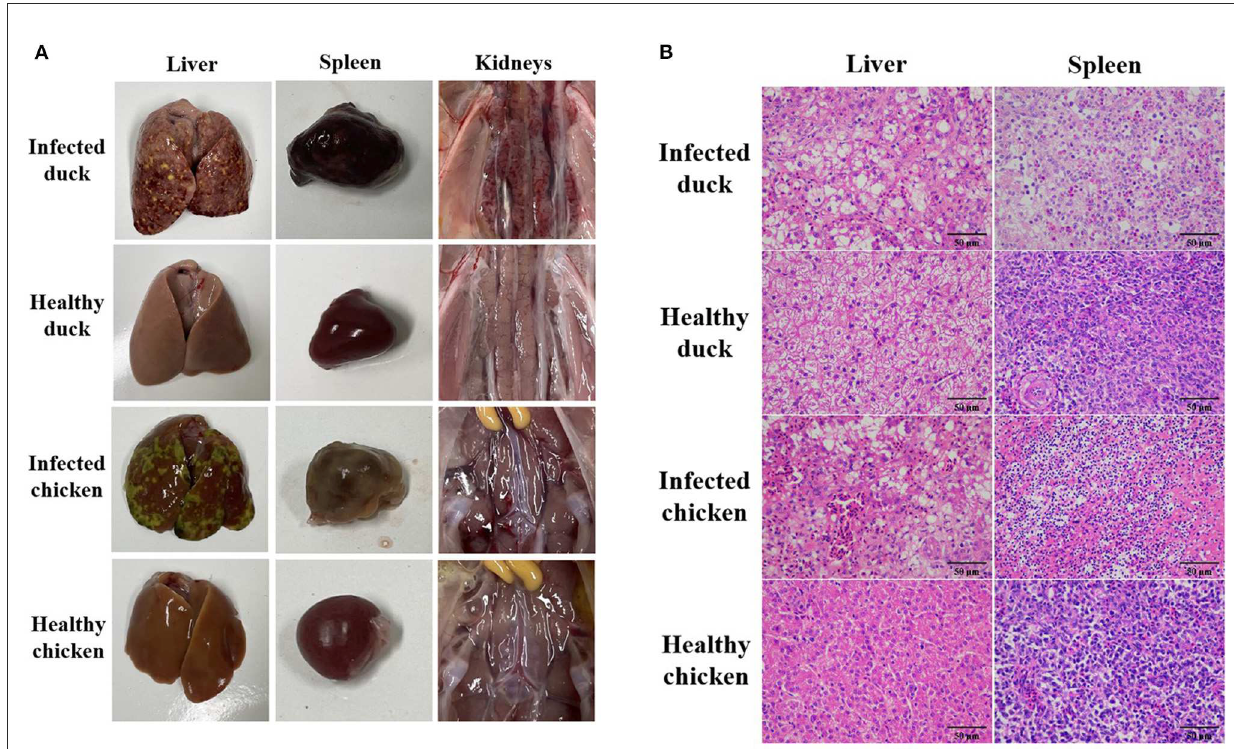
FIGURE3 Pathological changes in ducks and chickens artificially infected with NDRV-FJ19 strain. (A) Gross lesions of duck and chicken. Hemorrhage and necrosis of the liver and the spleen, and severe hemorrhage and swelling of kidneys in infection group. (B) Histopathological changes of duck and chicken. Scale bar: 50 µ m. In infection group, HE-stained liver section showing hemorrhage in liver tissue and swelling of hepatocytes. HE-stained spleen section showing diffuse hemorrhage and necrosis of splenocytes; many splenic lymphocytes have atrophic nuclei.